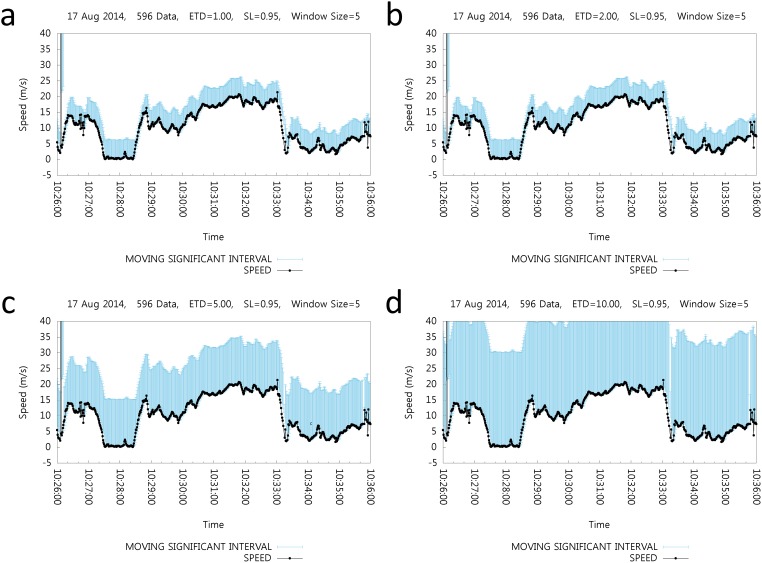
Effect of Distance Error Tolerance ET
d.